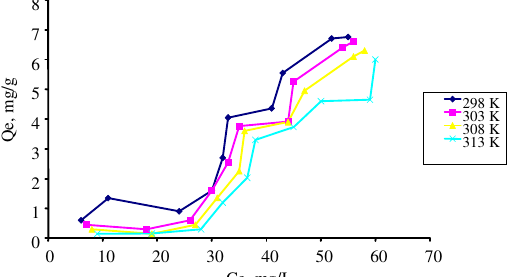
Figure 9. Effect of temperature on the adsorption capacity of dye A with charcoal at pH 12